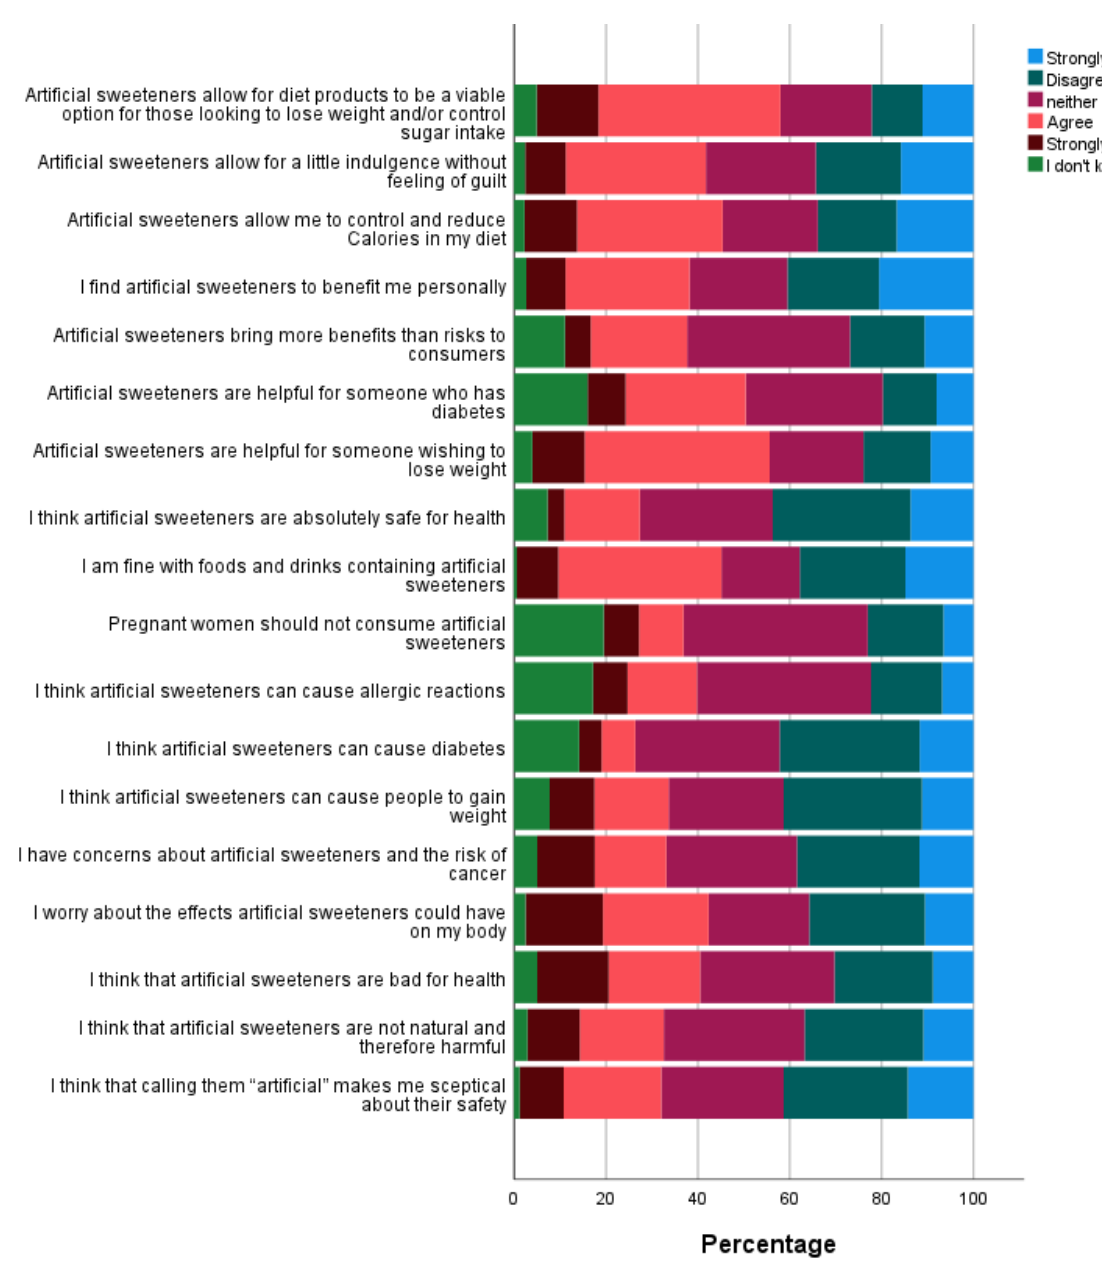
Figure 2. Benefits and safety perceptions of NNS.